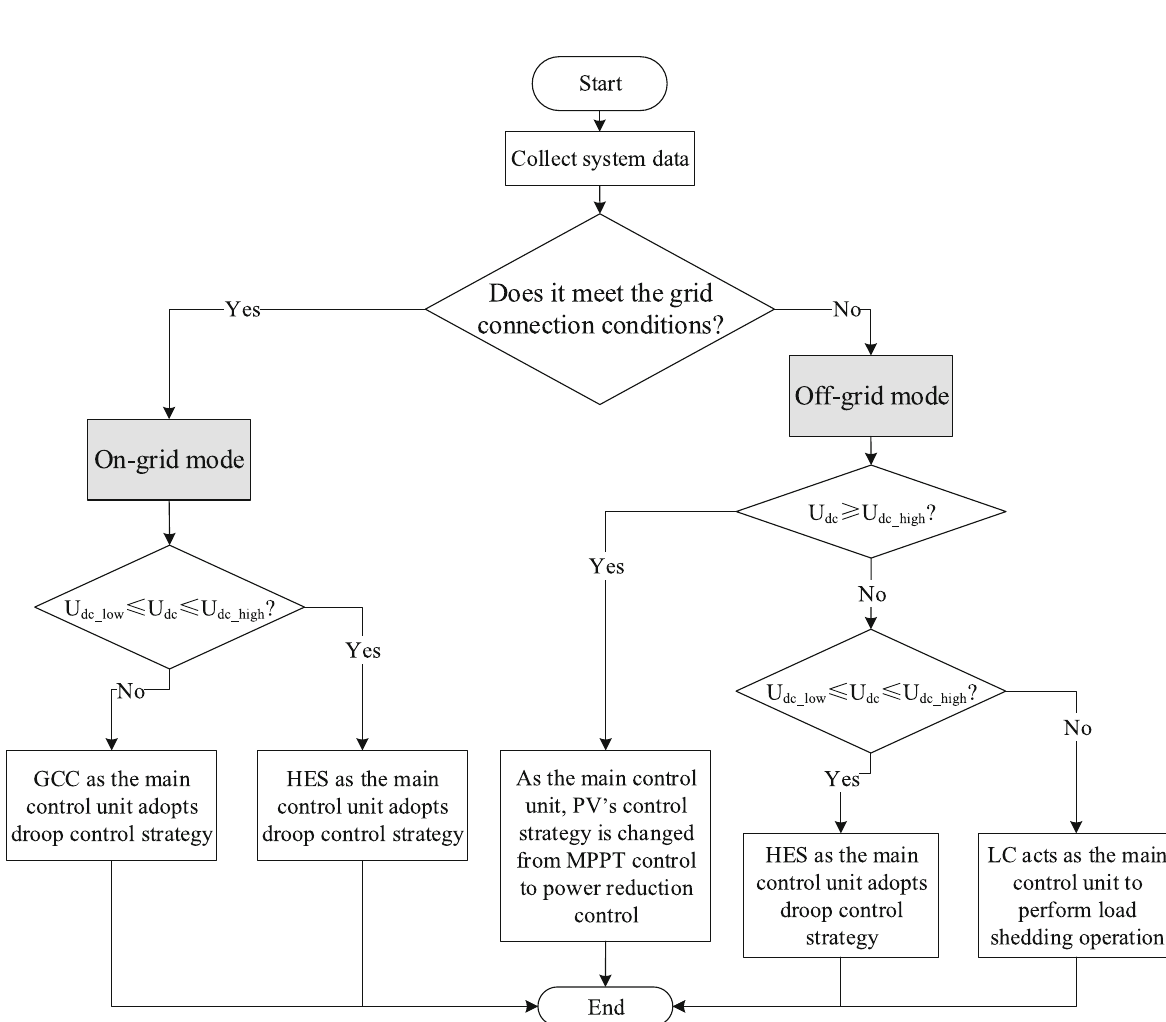
Fig. 9 Flow chart of Power control strategy for a household-level